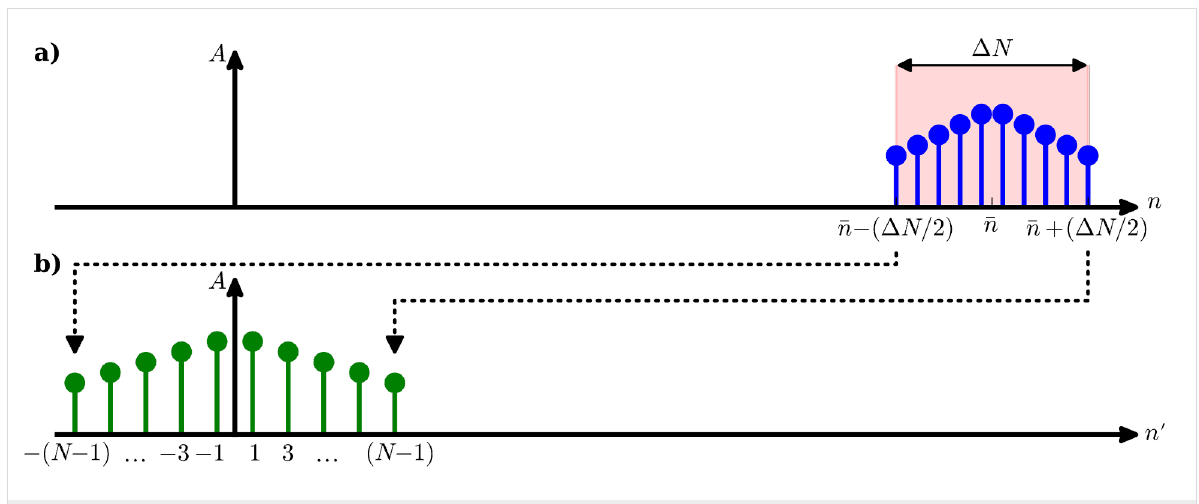
Figure 2: The amplitude spectrum of a narrow band signal as a function of the Fourier index (a) is characterized by a finite number of Fourier compo- nents in a frequency band around the center frequency = Δω , in a bandwidth that is given by the integer number Δ N . The spectrum of the corresponding time-dependent envelope function (b) is obtained by down-shifting the original spectrum in frequency space such that the shifted center frequency is